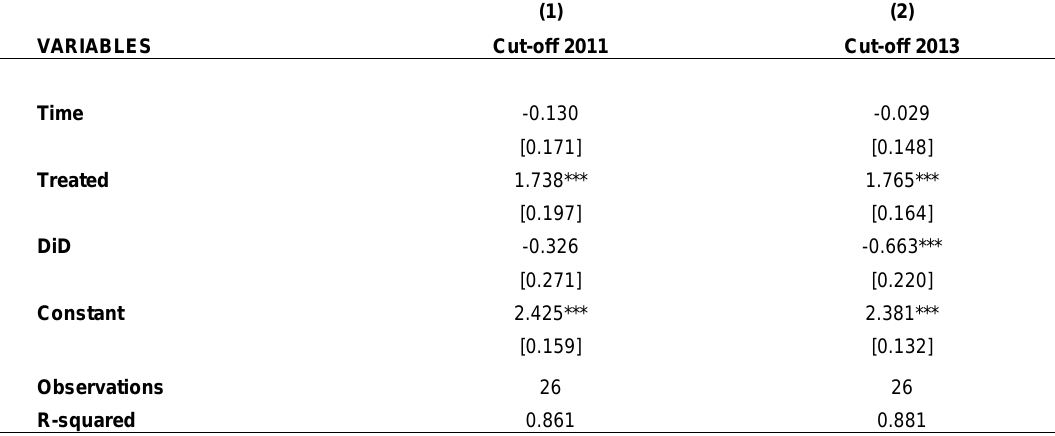
Table 5. Difference-in-Difference outcomes for Ticino and donor pool canton average unemployment